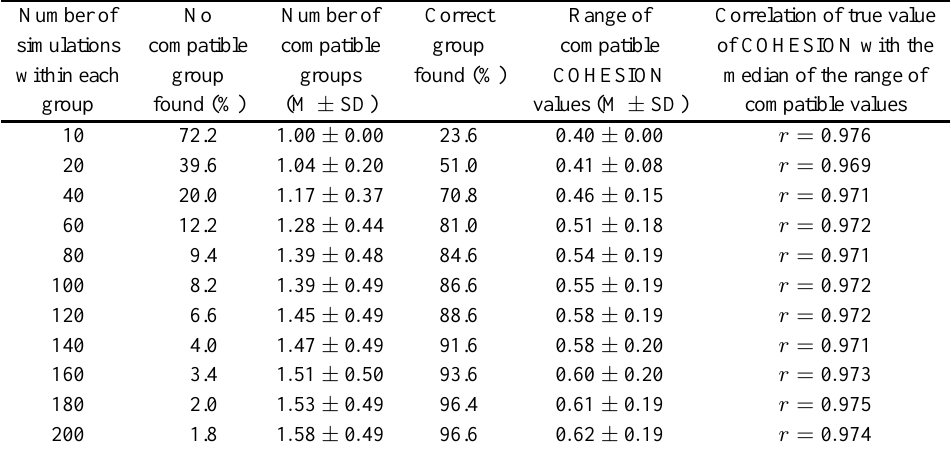
Pattern interpretation in simulated tumour patterns using cellular automata. Variation of a single parameter (COHESION). Influence of the number of simulations within each group. 5 categories were used.